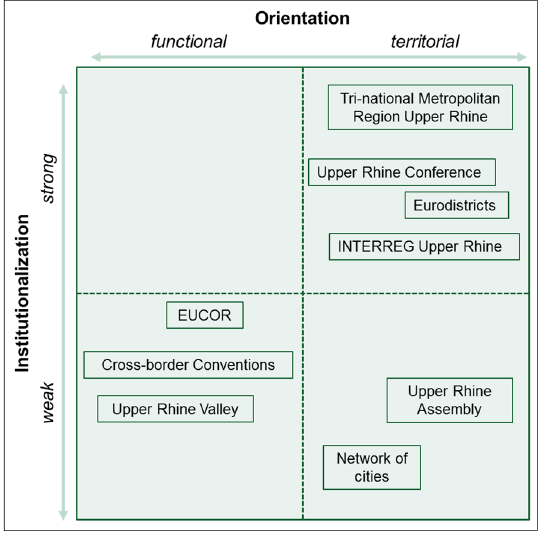
Figure 4. Cross-border organizations in the Upper Rhine Region. Source: Authors’ own